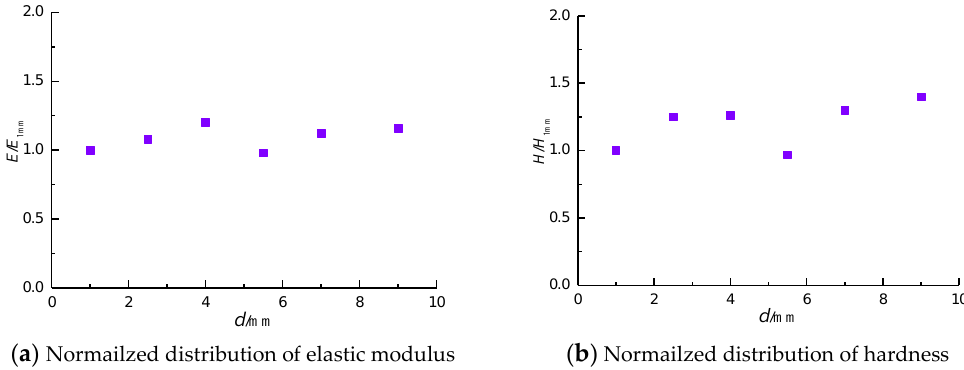
Figure 11. The effect of the indentation position on the indentation test. Figure 11. The e ff ect of the indentation position on the indentation